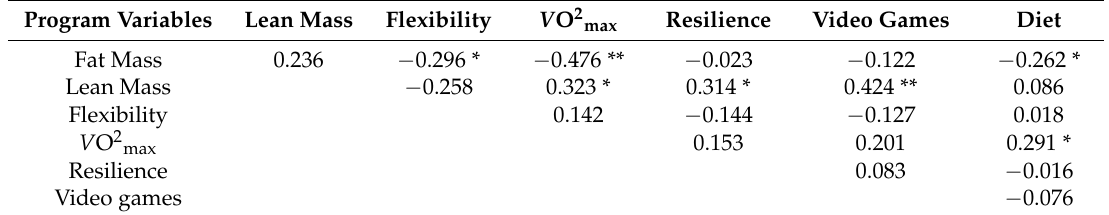
Table 4. Bivariate correlations between variables studied after the intervention